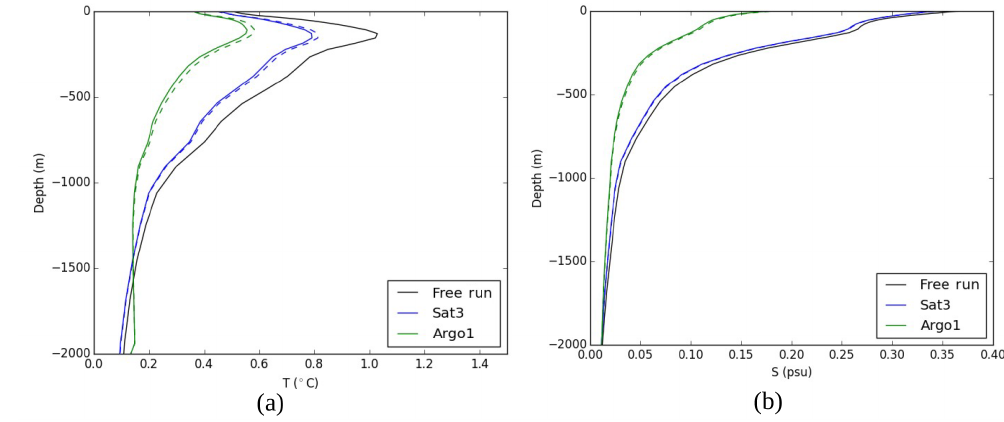
Figure 15. Global 7-day forecast RMSE of T (a) and S (b) profiles respectively in C ◦ and PSU for FR (black), Sat3 (blue) and Argo1